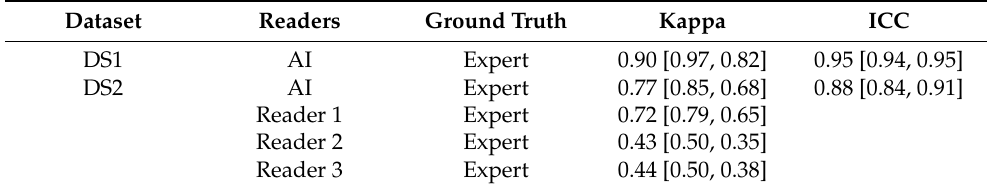
Table 4. Agreement of AI predictions with scores provided by expert and non-expert readers. The 95% Confidence Intervals (CIs) of each value is provided in square